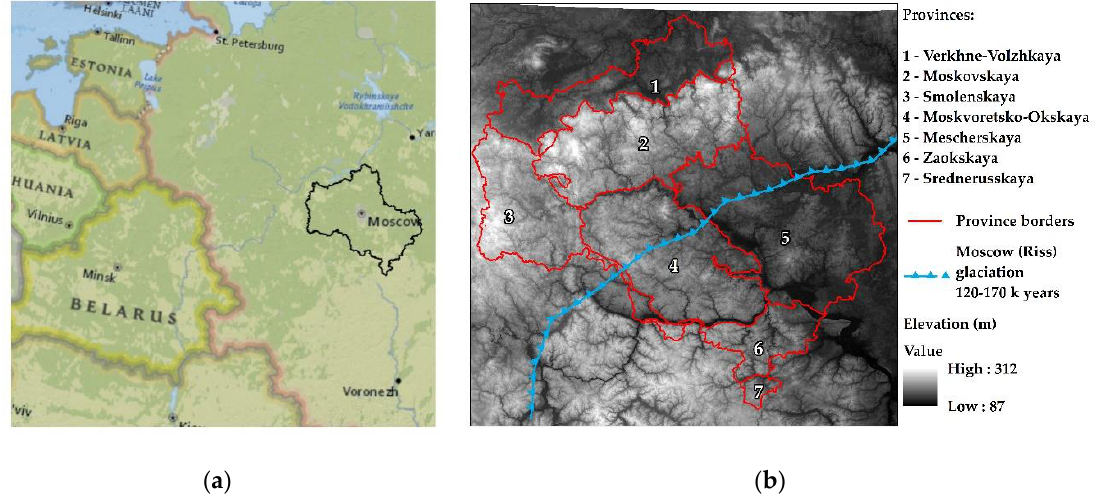
Figure 1. ( a ) Location of the study area, ( b ) physiographic provinces and terrain of the Moscow Region.